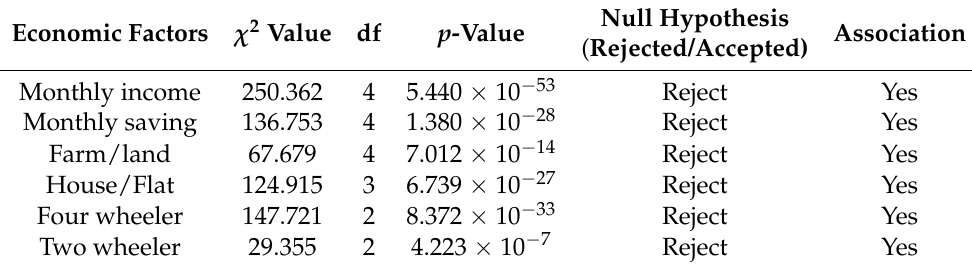
Table 3. Results of χ 2 test on economic factors and buying behaviour of buyers and non-buyers of a life insurance